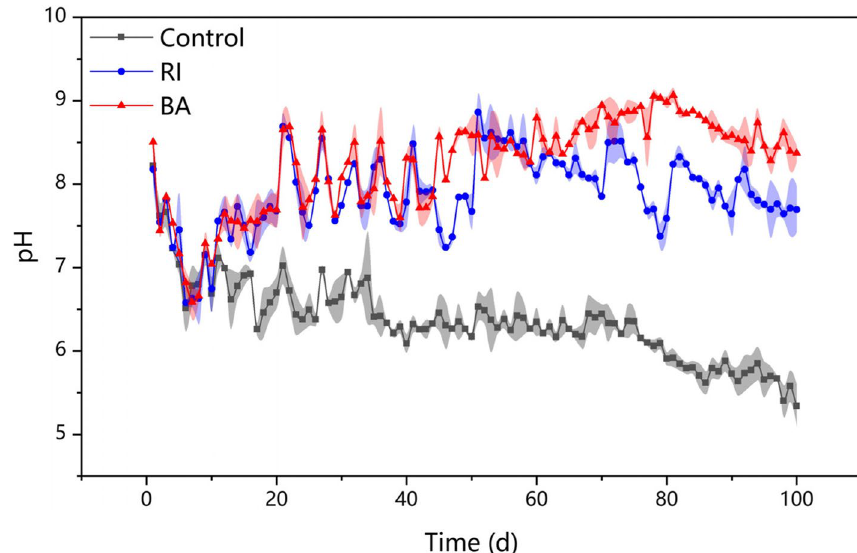
Fig. 3 Variations in pH in different reactors. Shaded areas indicate error